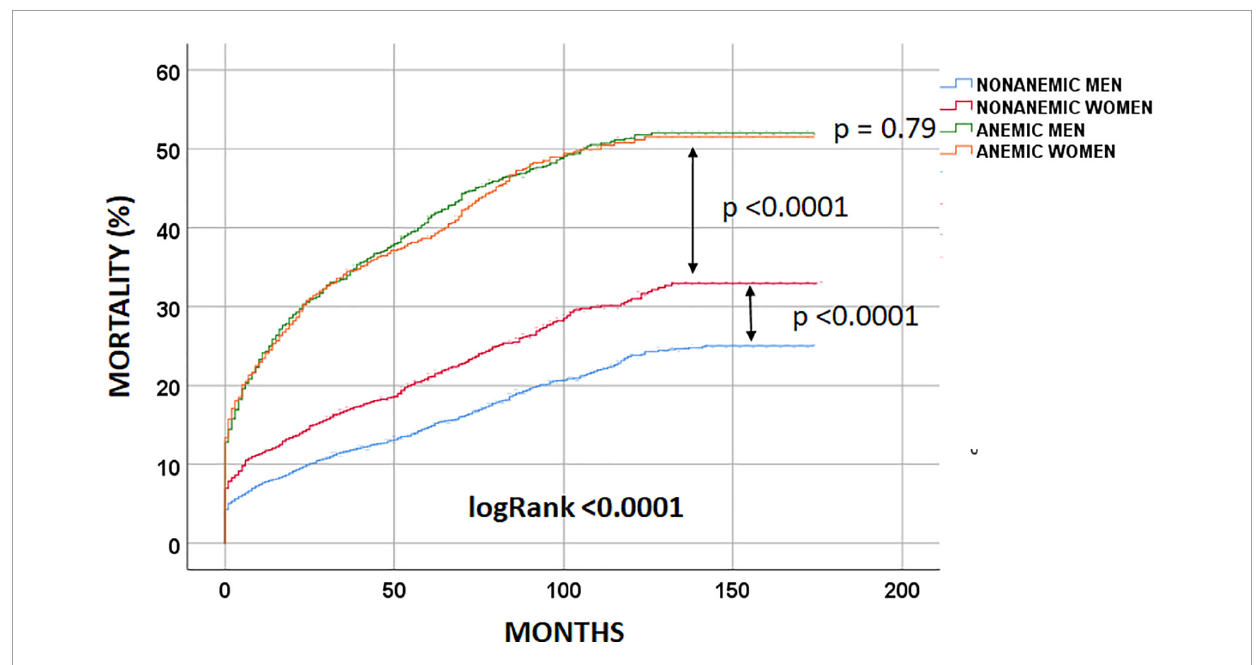
FIGURE2 Unadjusted long-term mortality.